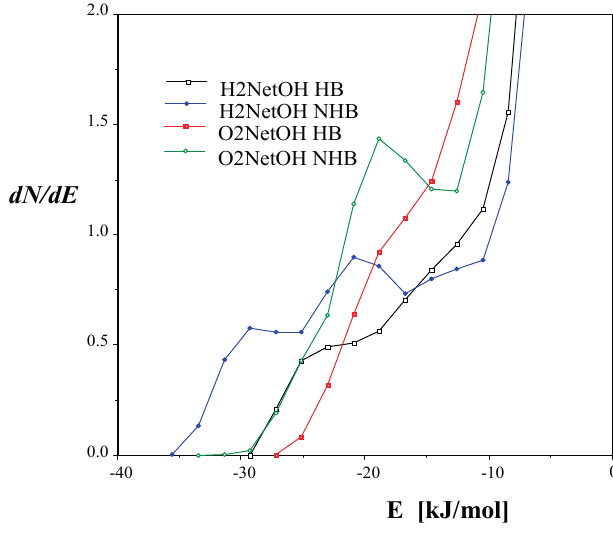
Figure 6. Solute-water pair-energy distribution functions for 2-aminoethanol and 2-NO 2 -ethanol with (HB) and without (NHB) an intramolecular H-bond: H 2 NetOH HB ( 7 ); H 2 NetOH NHB (8 ); O 2 NetOH HB ( 9 ); O 2 NetOH NHB ( 10 ). Structure numbers from Figure